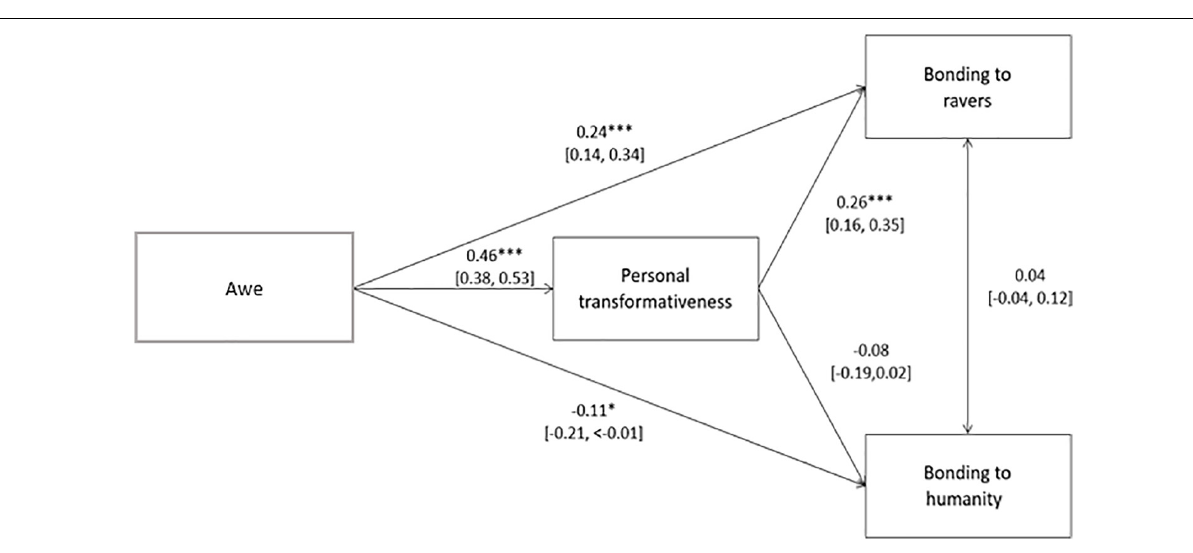
FIGURE 5 | Mediation model predicting bonding to ravers and humanity from awe via personal transformativeness. Standardized beta coefficients with 95% CIs. ∗ p < 0.05, ∗∗ p < 0.001, ∗∗∗ p <